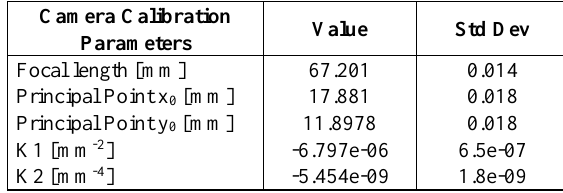
Table 1. Nikon D800E Camera Calibration